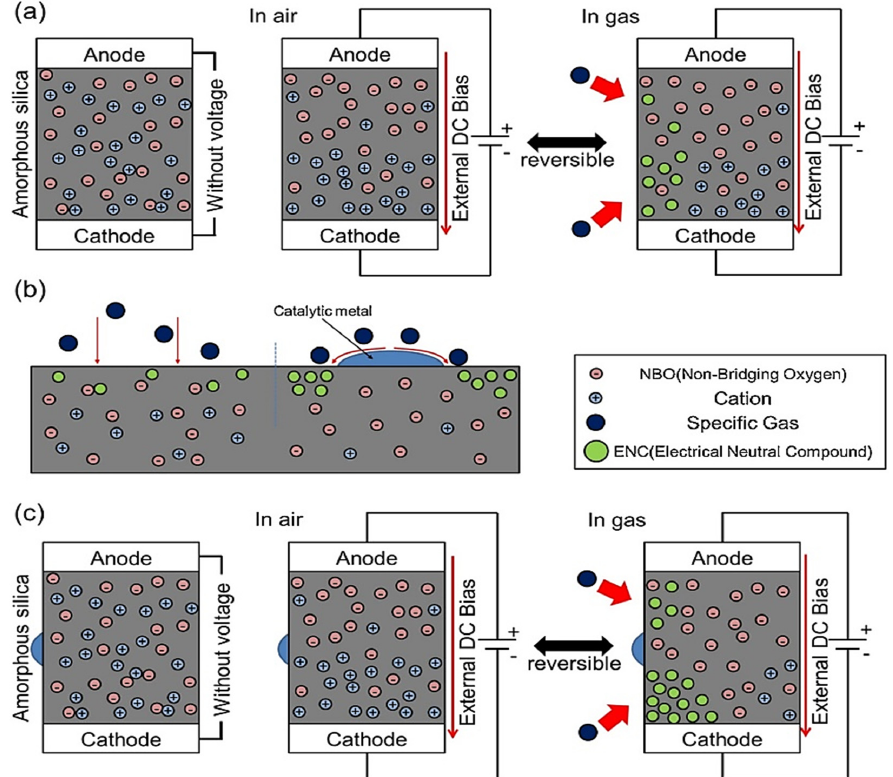
Figure 36. Schematic demonstrating the detection mechanism of noble-metal-functionalized soda- lime glass. ( a ) Reversible change in soda-lime glass upon the introduction and removal of target gas. ( b ) Spillover effect due to metal functionalization. ( c ) Reversible change in the metal-functionalized soda-lime glass by the introduction and removal of the target gas. Reproduced from [157] with the permission of Elsevier.